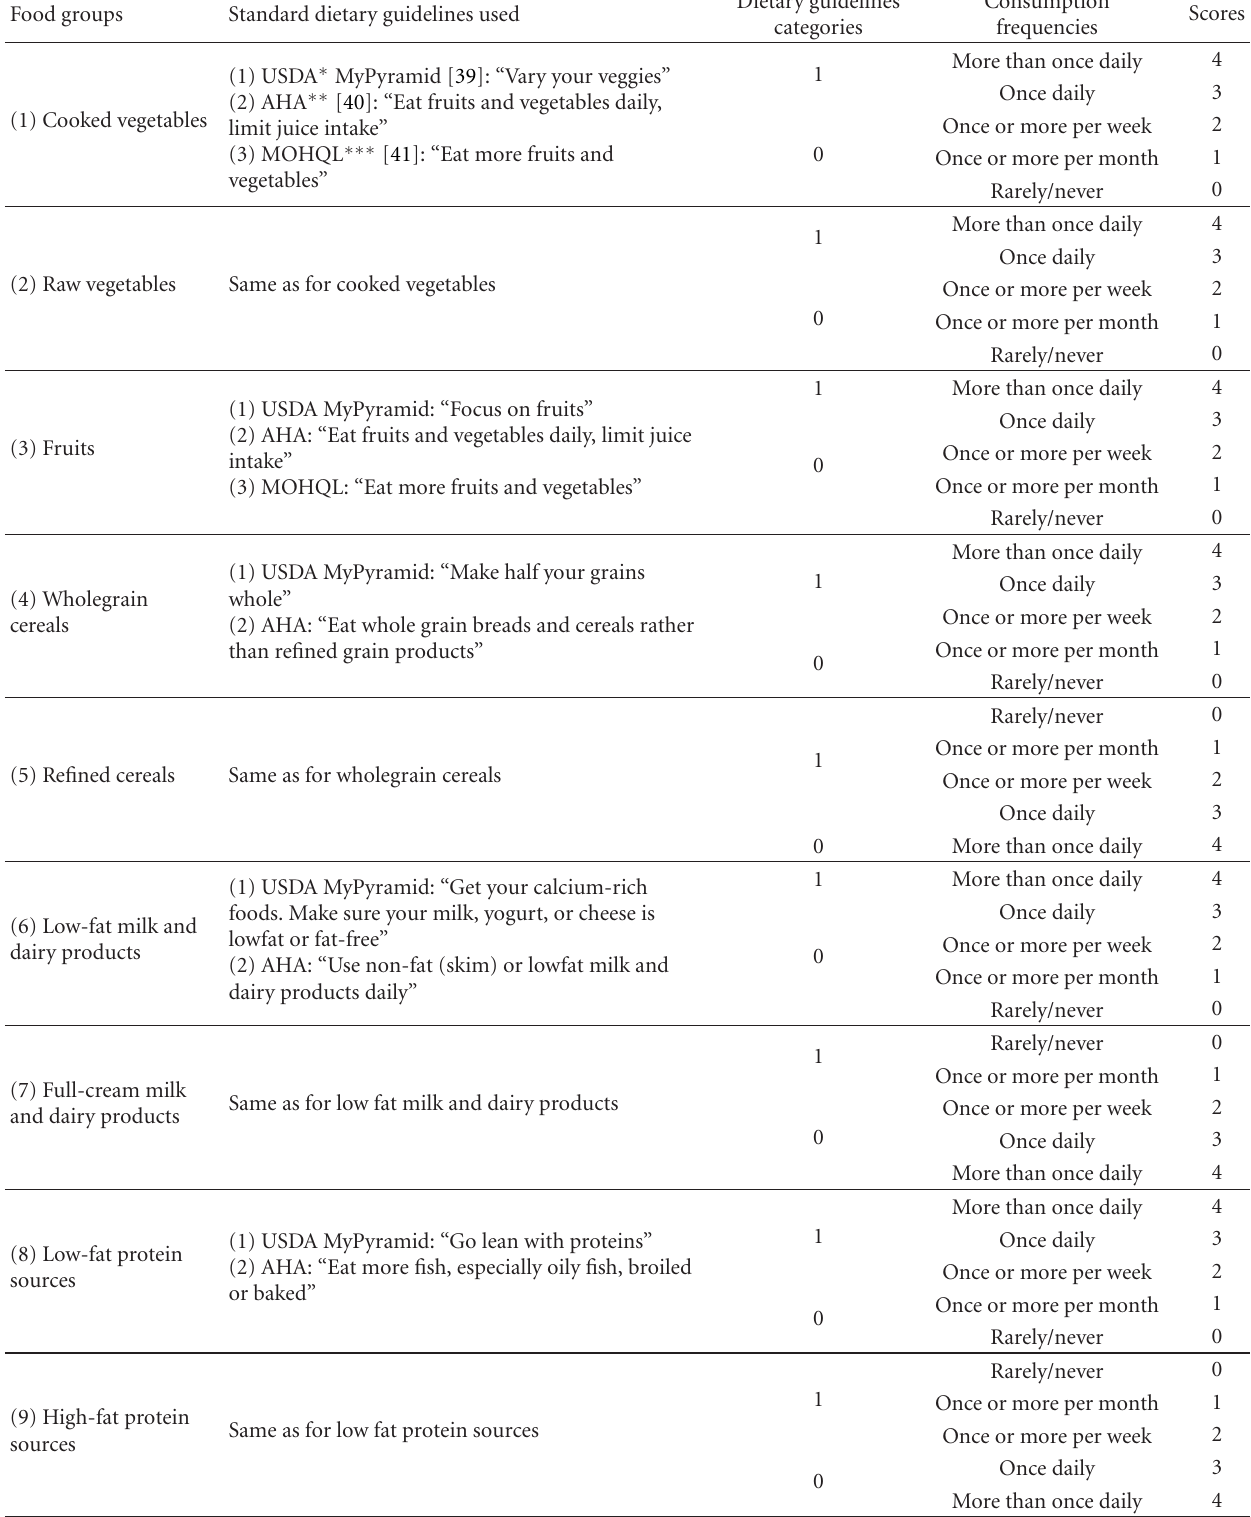
Table 1: Classification of food groups according to dietary